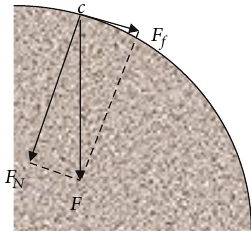
Figure 3: Detail view of the disc force.